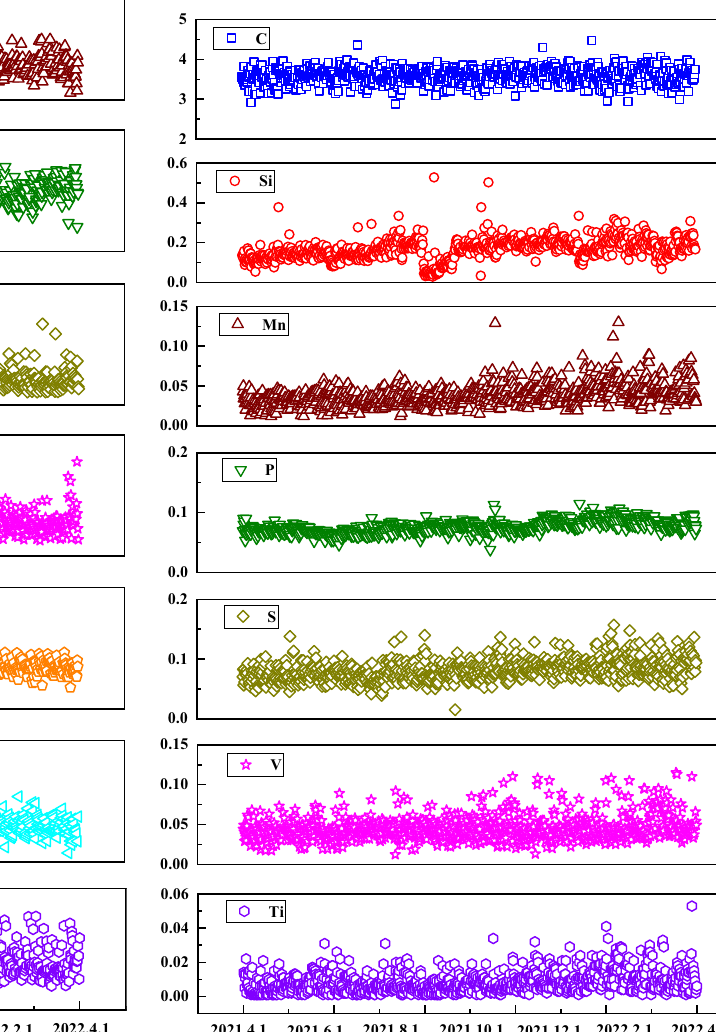
Figure 7: Composition ( wt% ) of semi - steel produced in the V - reco - vering BOF over the 1 year ( 2021 – 2022 )